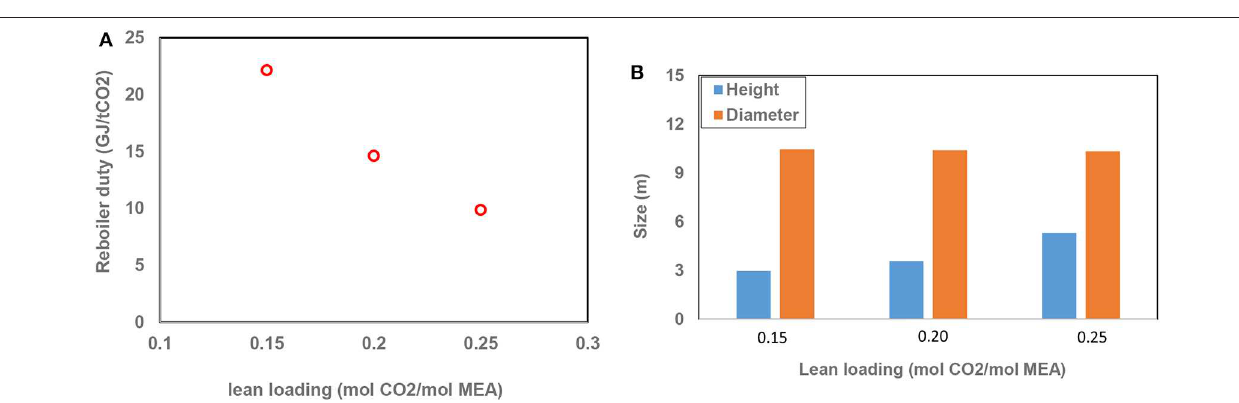
FIGURE 3 | (A) Reboiler duty and (B) absorber size variations with lean